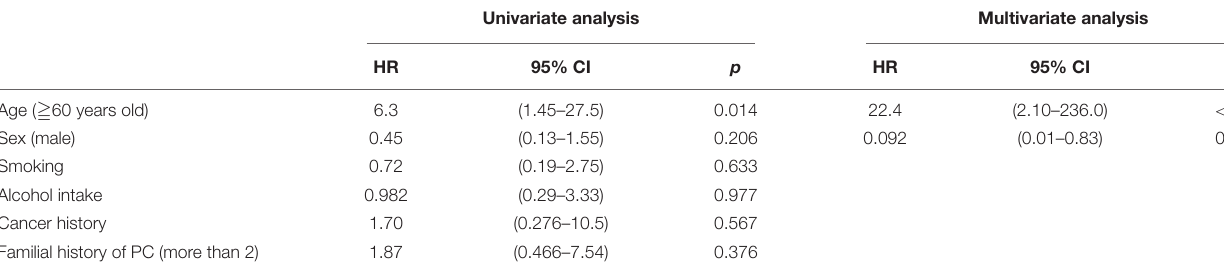
TABLE 6 | Results of analysis of factors related to the early chronic pancreatitis.